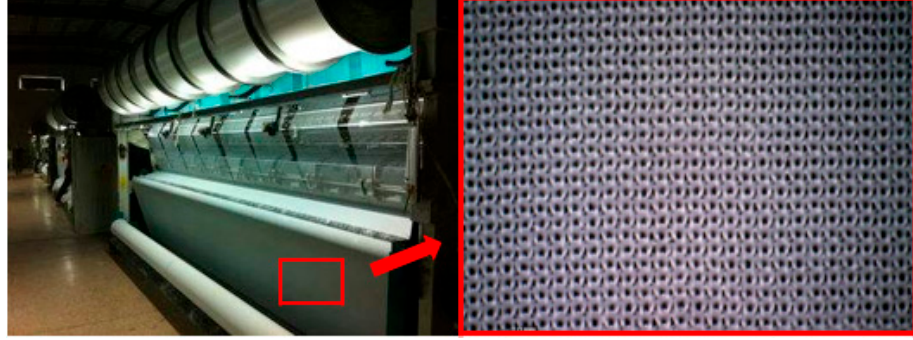
Figure 2. Fabrics knitted on the warp-knitted machine.